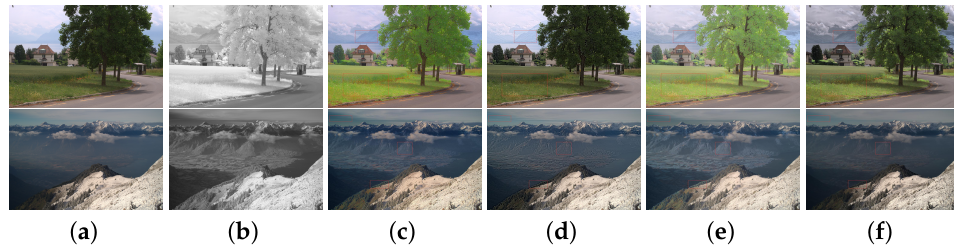
Figure 10. Fusion results for RGB VIS and IR images. ( a ) VIS. ( b ) IR. ( c ) Fusion by [35]. ( d ) Fusion by [8]. ( e ) Unstretched. ( f ) Stretched.